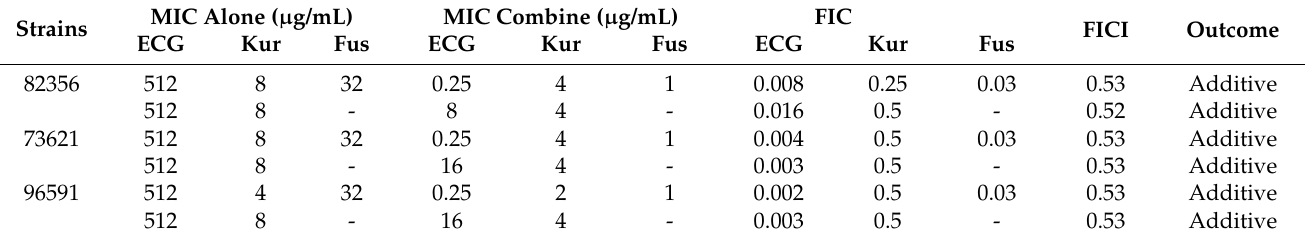
Table 4. Minimum inhibitory concentrations (MIC) ( µ g/mL) and fractional inhibitory concentration indices (FICI) of kuraridin and epicatechin gallate (ECG) with antibiotics against fusidic acid (Fus) resistant MRSA strains.